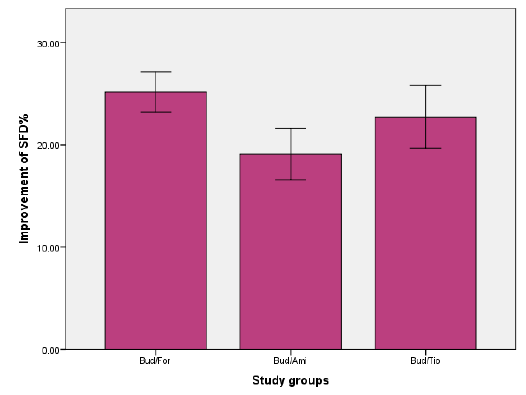
Figure 6. Comparison of groups according to extent of change in percentages of SFDs during the first four weeks of study *: significant difference compared to first and second groups Bud/For (First group): Budesonide/Formoterol Bud/Ami (Second group): Budesonide/Aminophylline Bud/Tio (Third group): Budesonide/Tiotropium The impact of medication regimens on the patients' MiniAQLQ scores was demonstrated in table 6. All study groups showed significant improvement at the first follow up visit compared to pretreatment levels and continued their significant improvement in the second follow up visit compared to the first follow up scores (p<0.001) .